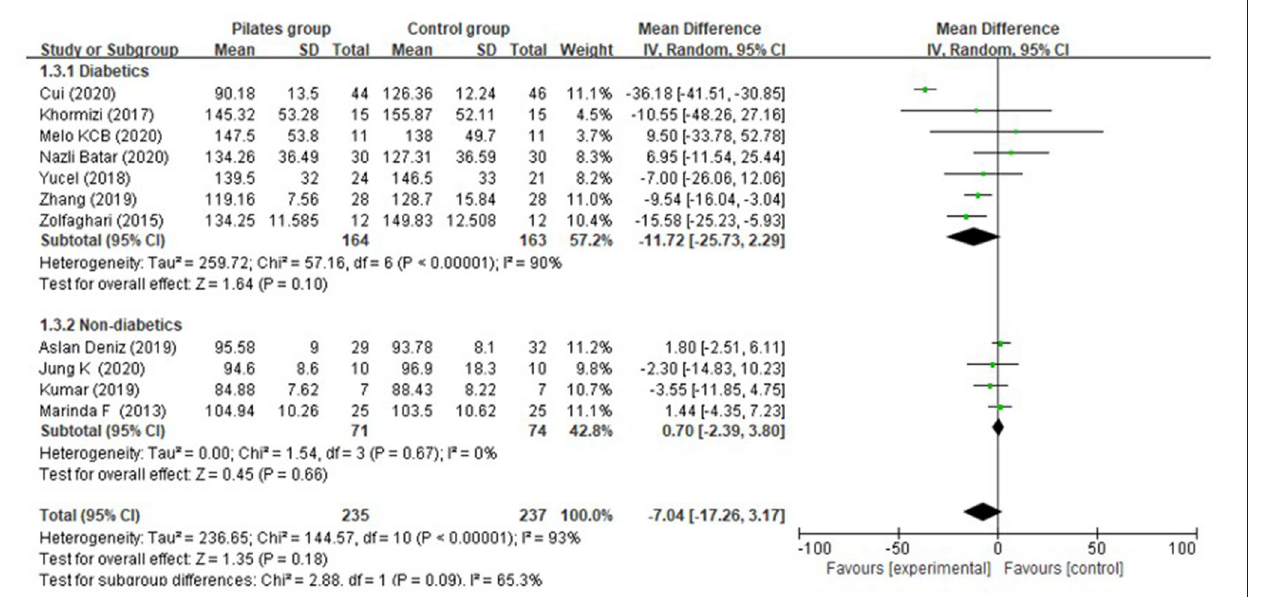
FIGURE 3 | Meta-analysis and forest plot for fasting blood glucose.